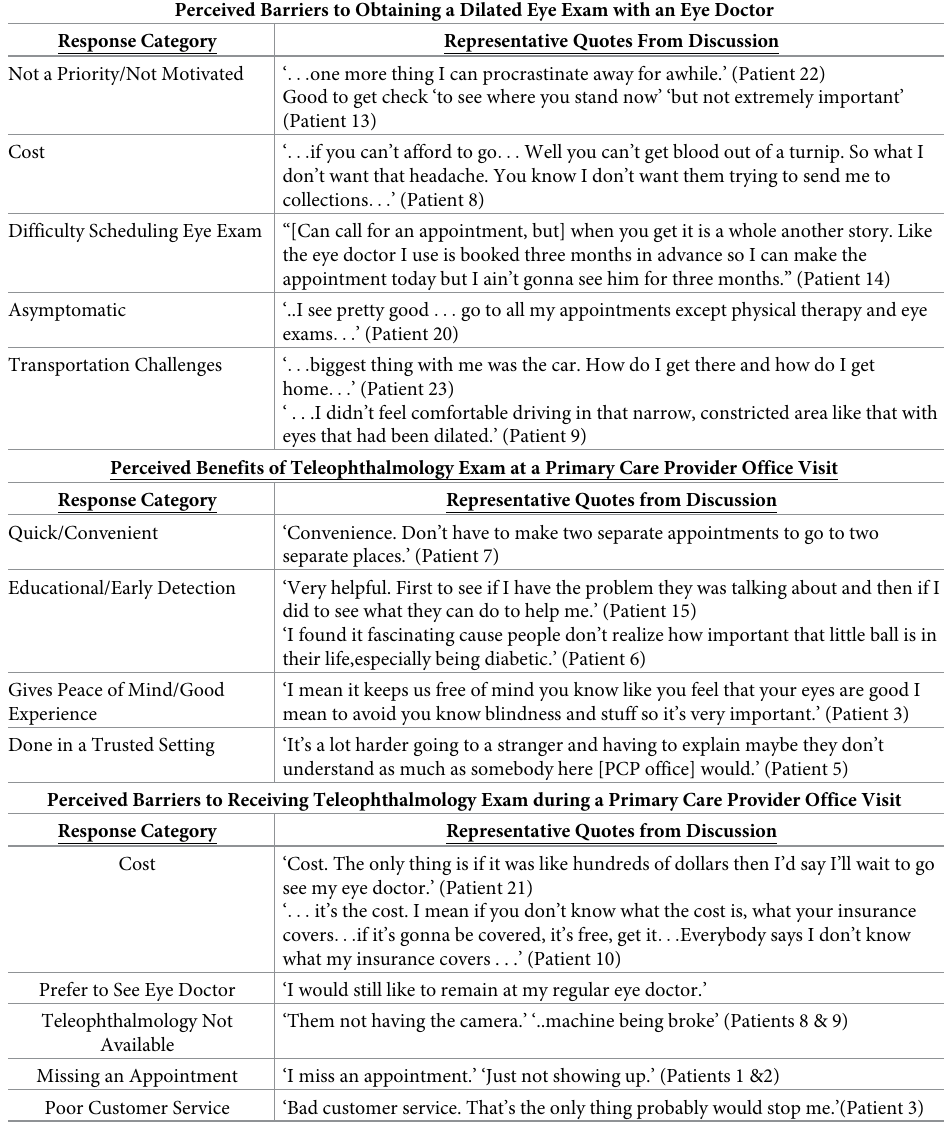
Table 2. Perceived barriers to receiving dilated eye exam and perceptions of